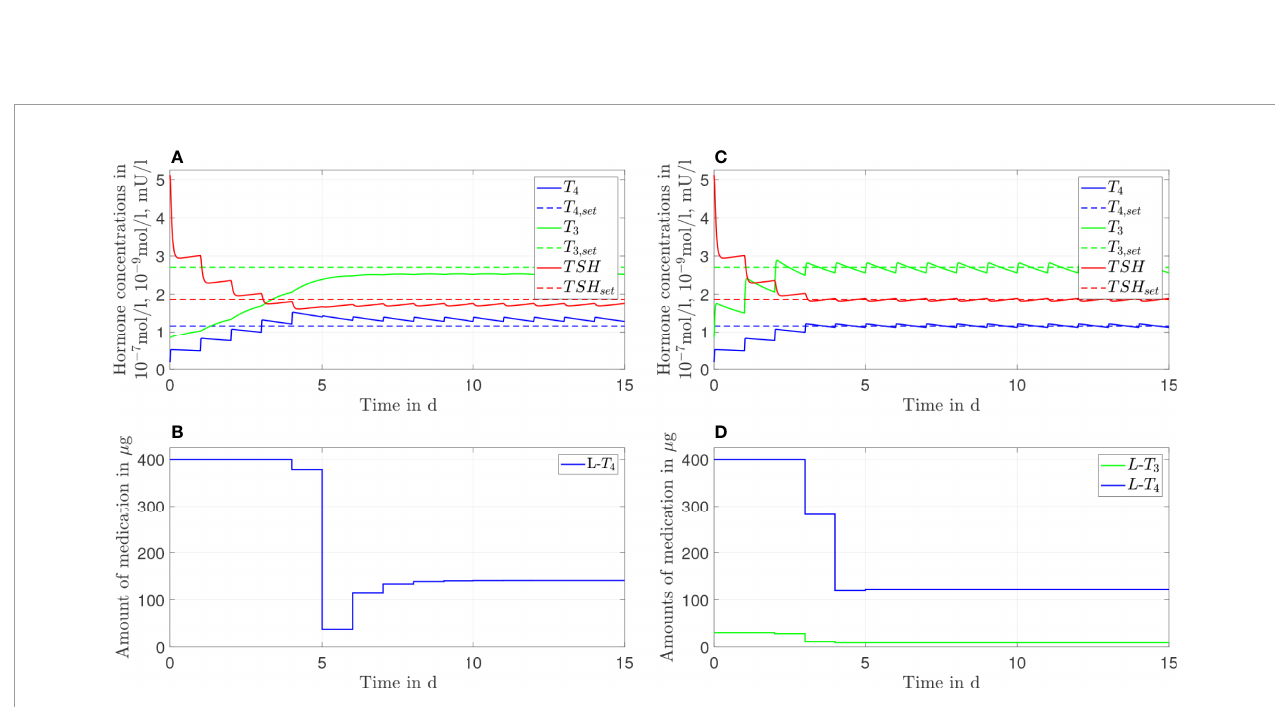
FIGURE 4 | Simulation results of an L-T 4 monotherapy (A, B) and an L-T 3 / L-T 4 combined therapy (C, D) for G' D1 = 0.9G D1 .